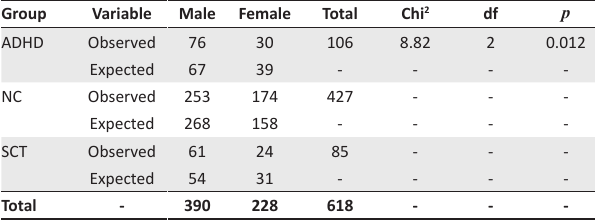
TABLE 2 : Gender distribution in the three groups. Group